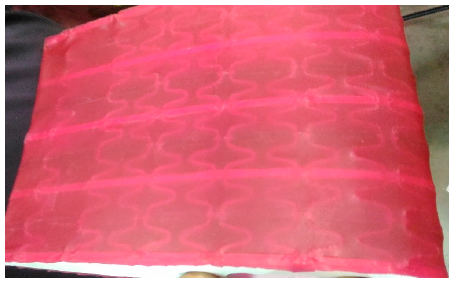
Figure 15. Pre-tensioned latex skin covering a wing partition.